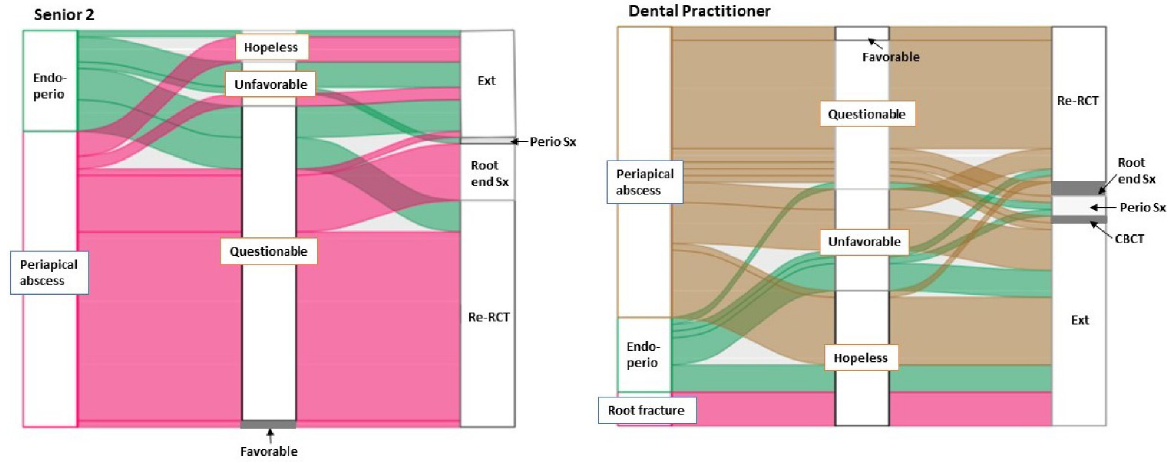
Figure 2. Distribution and correspondence of the diagnosis, prognosis, and treatment choice for Case B between the Senior 2 ( n = 63) and Dental practitioner ( n = 59) groups. Endo-perio = endodontic periodontal combined lesion, Ext = extraction, Sx = surgery, RCT = root canal therapy, CBCT = cone-beam computed tomography.